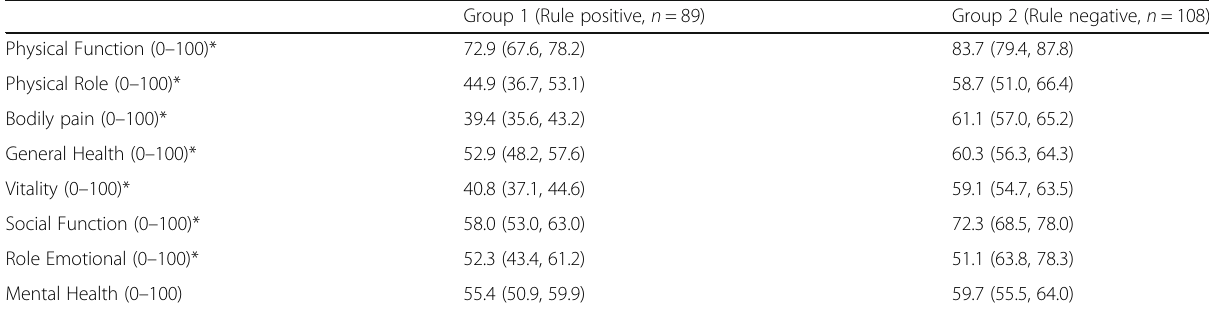
Table 3 Differences in health-related quality of life in individuals with tension-type headache by